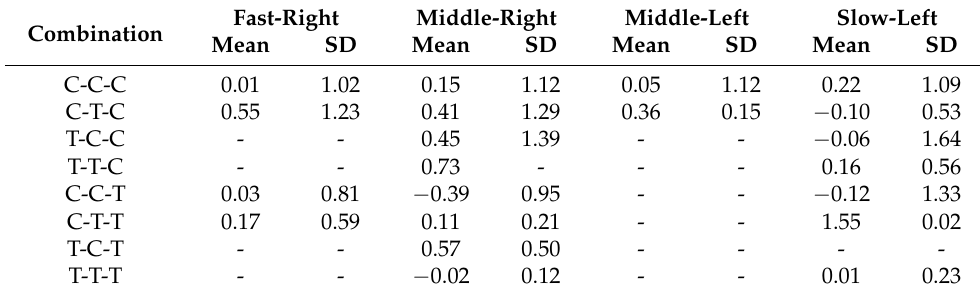
Table 4. The mean and standard deviation of T b difference between n3 and n5.